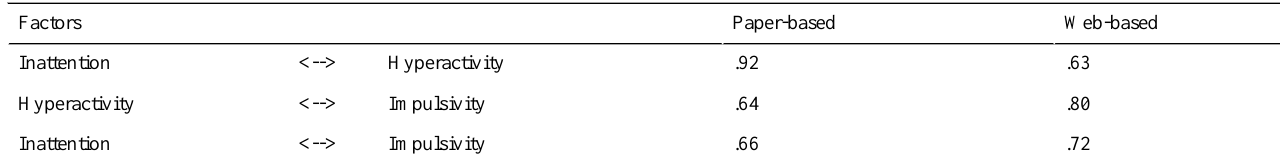
Table 8. Intercorrelations between the ADHS-SB factors (latent constructs) in the paper-based and Web-based samples.